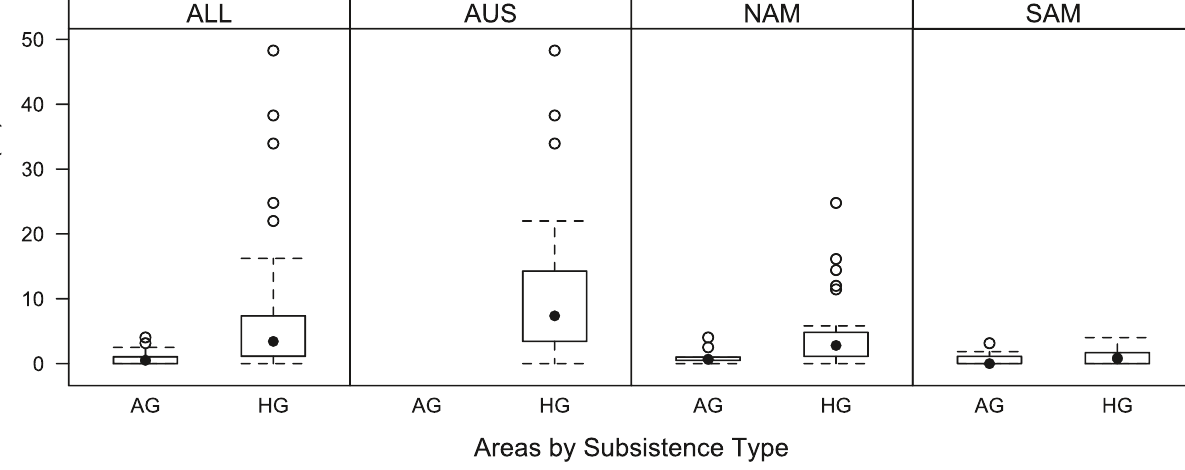
Figure 2. Subsistence patterns. Box-and-whiskers plot of Case Study Area loan data, split by subsistence type (HG=hunter-gatherers, AG=agriculturalists).